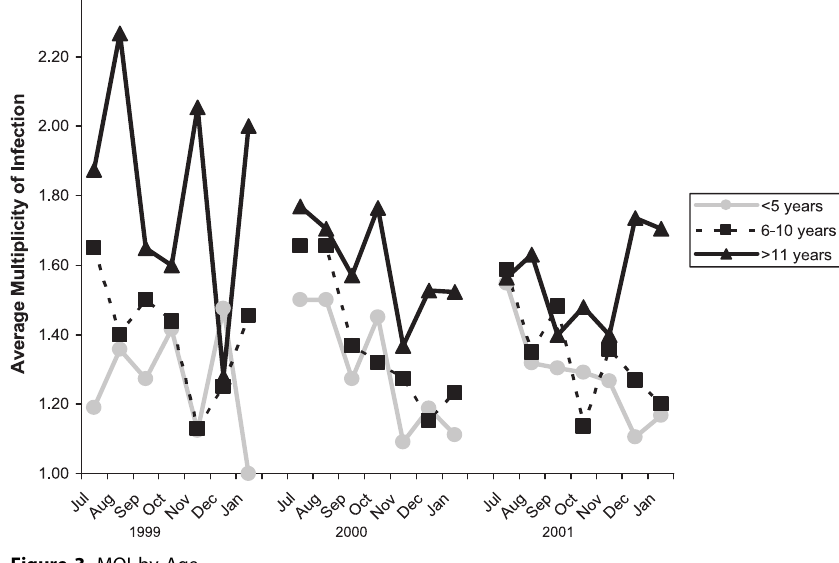
Figure 3. MOI by Age Average MOI over time in three age groups.